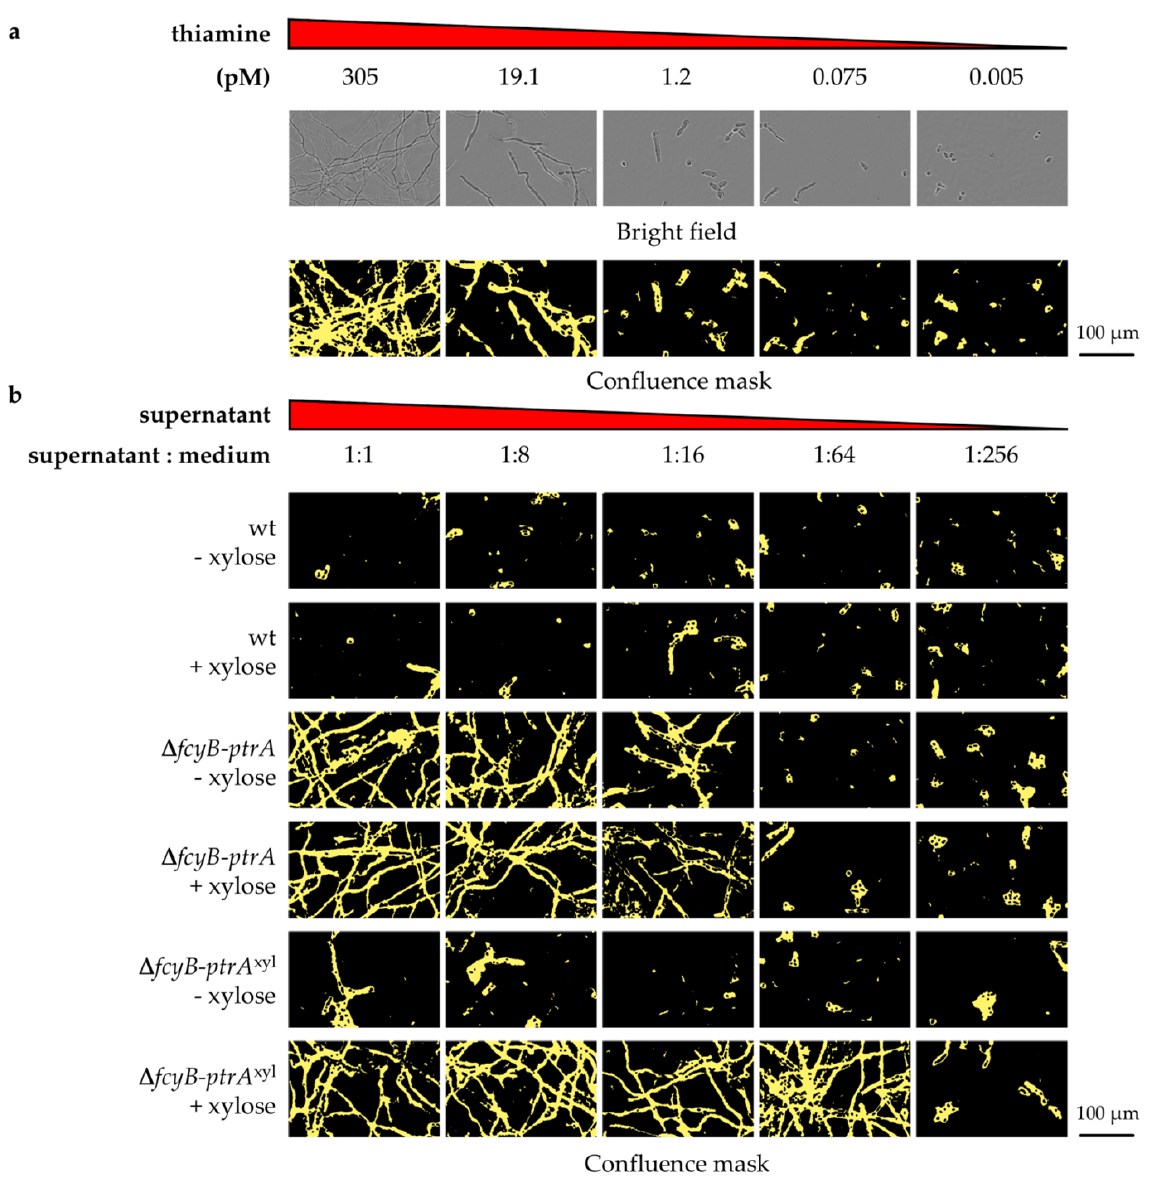
Figure 5. Fungal growth of reporter strains according to thiamine or putative thiamine equivalent concentration in the medium. Thiamine or culture supernatant were subjected to a serial dilution procedure starting with 1:1 dilution of supernatant with medium in well number 1. ( a ) A52 growth in the presence of decreasing concentrations of thiamine. The complete dilution series is shown in Figure S4. ( b ) A52 growth pattern in the presence of decreasing concentrations of A. fumigatus wt, ∆ fcyB-ptrA, and ∆ fcyB-ptrA xyl supernatants from 18 h cultures either in the presence or absence of xylose. For simplicity, phase images are omitted, and only confluence mask images are shown. Phase images and complete dilution series are shown in Figure